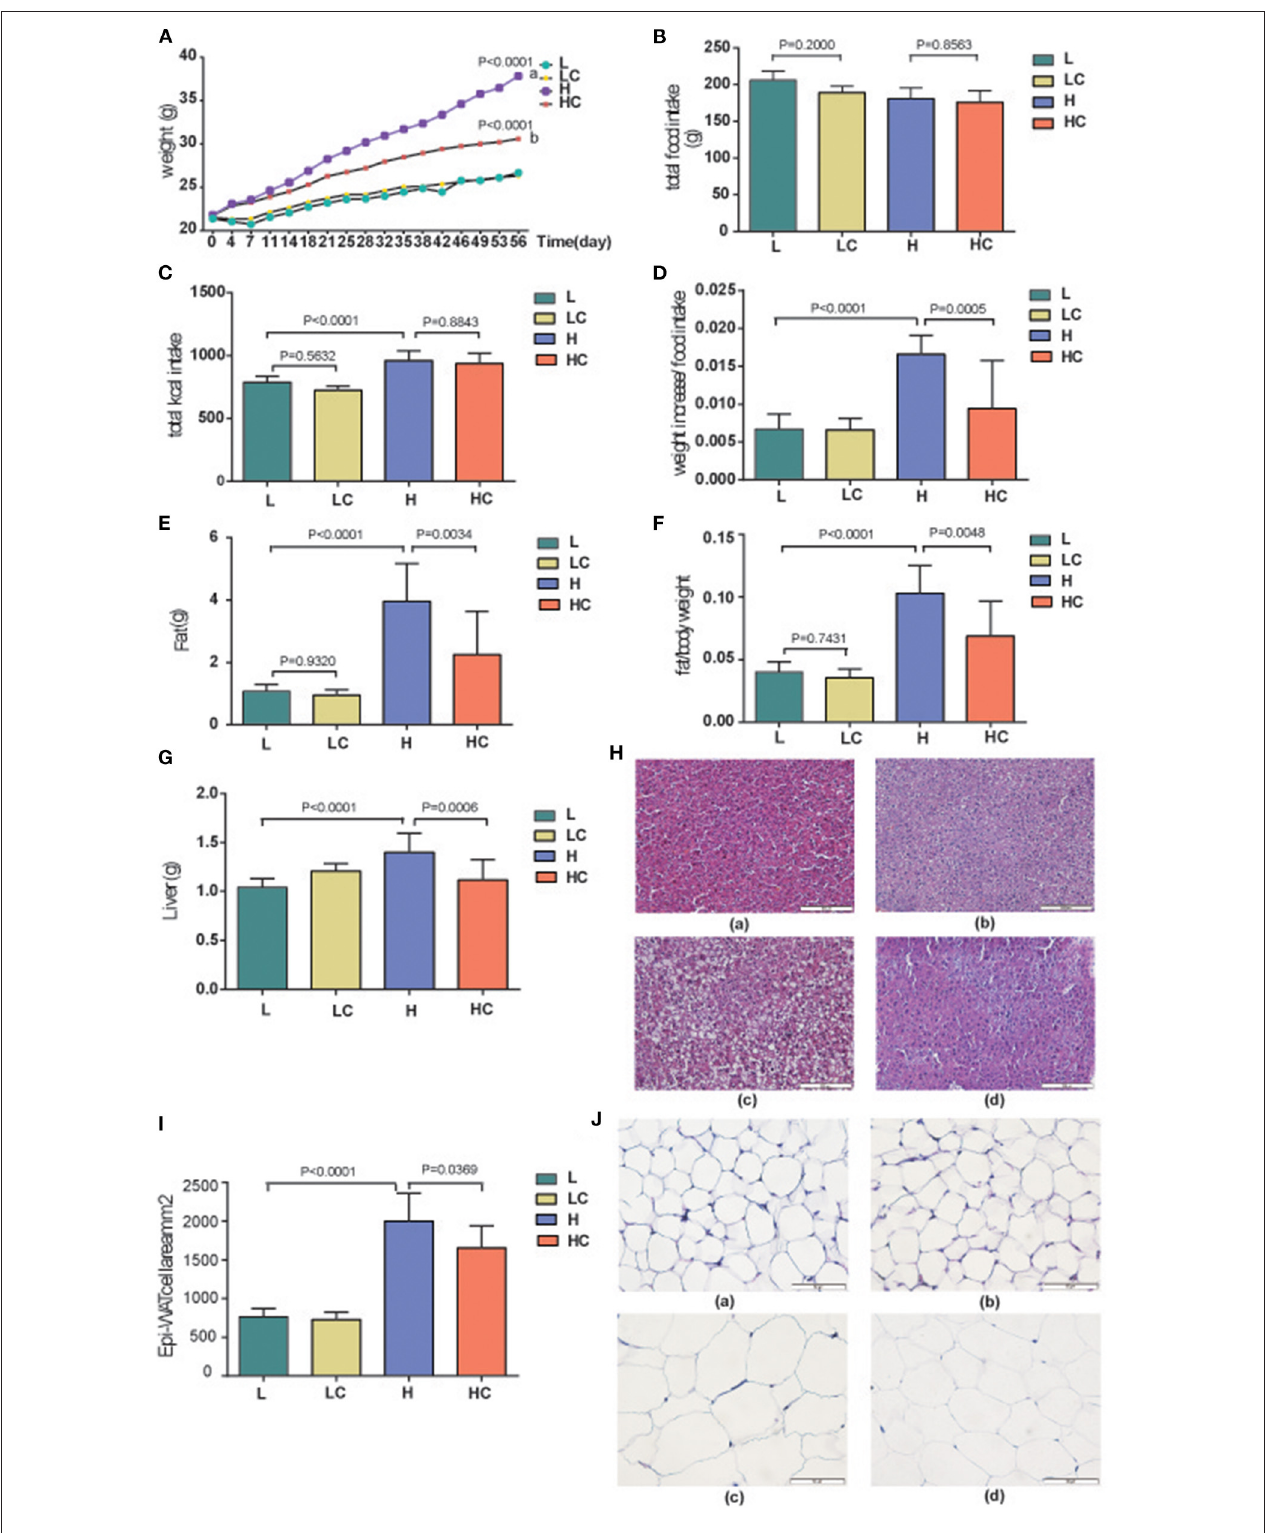
FIGURE 1 | Effects of COS on Body weight and liver fat. (A) Changes in mouse body weight over time; (B) Food intake of mice in each group; (C) Calculated energy intake of each group; (D) Weight increase per unit different diet; (E) Average fat weight of each group; (F) Average BFR, body fat rate; (G) Average liver weight of different groups; (H) H&E staining of liver in the L (a), LC (b), H (c), and HC (d) groups; (I) The size of Epi-WAT cells; (J) H&E staining of Epi-WAT in L (a),